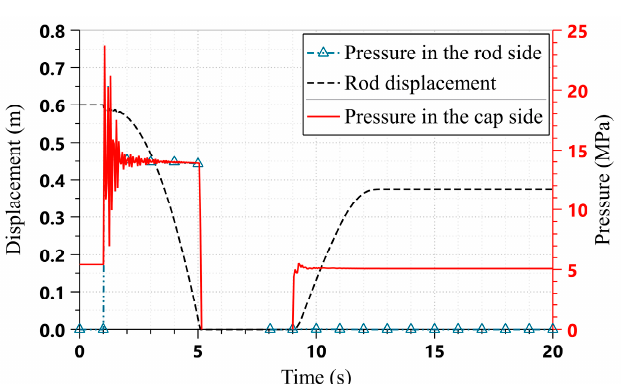
Figure 18. The boom cylinder piston displacement and the pressures in the two chambers of the boom cylinder for the FFERS with a variable transmission ratio.